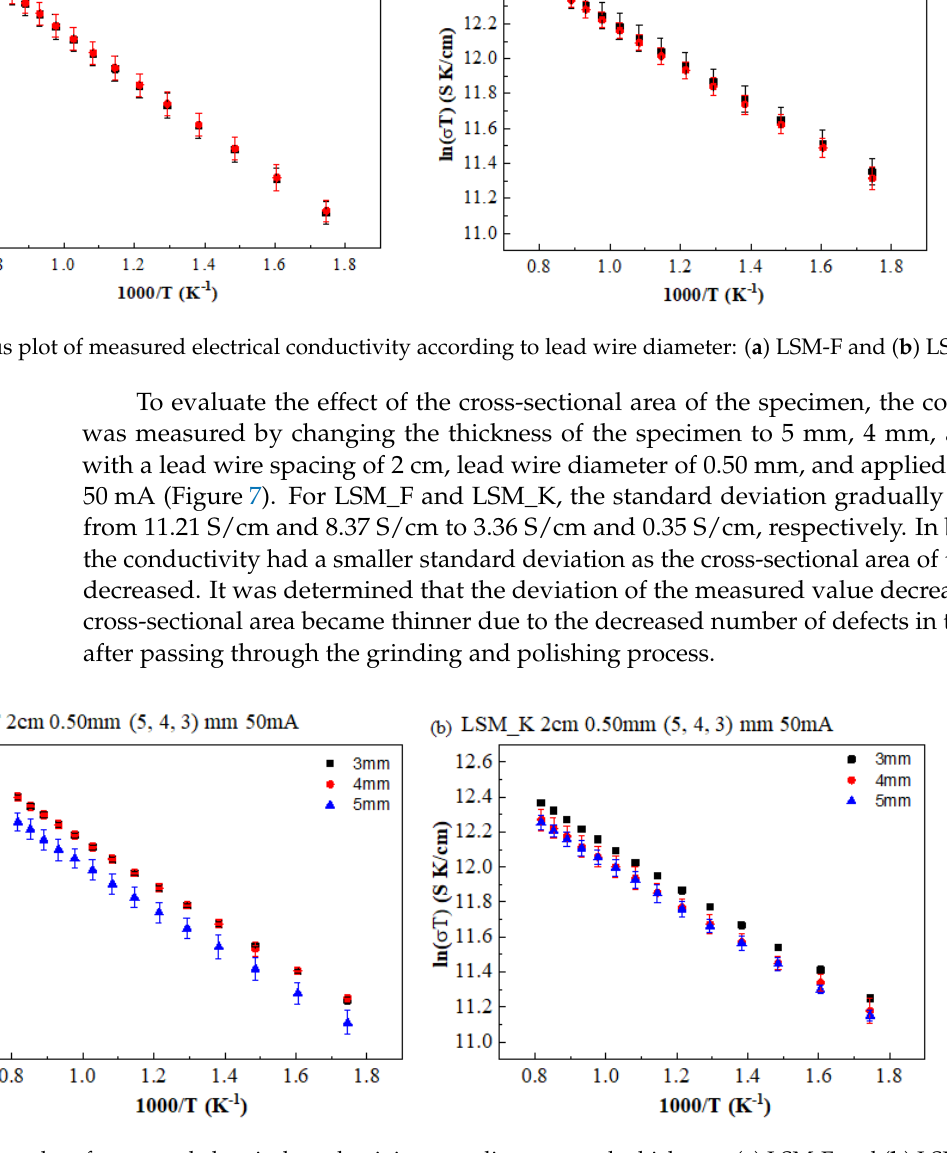
Figure 7. Arrhenius plot of measured electrical conductivity according to sample thickness: ( a ) LSM-F and ( b ) LSM-K.